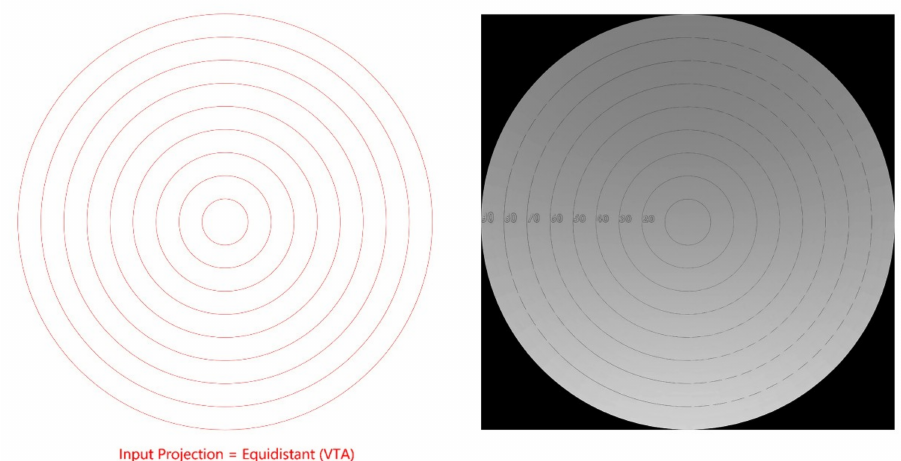
Figure 16. The mathematical projection of equidistance on the left, and the benchmark image of hemisphere with Theta rings created in Radiance on the right (Source: the